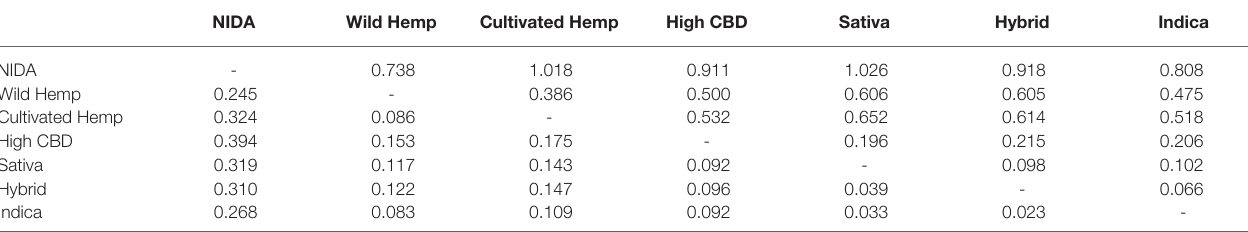
TABLE 1 | Pairwise Fst values (below the diagonal) and Nei’s D (above the diagonal) for major Cannabis groups. NIDA Wild Hemp Cultivated Hemp High CBD Sativa Hybrid